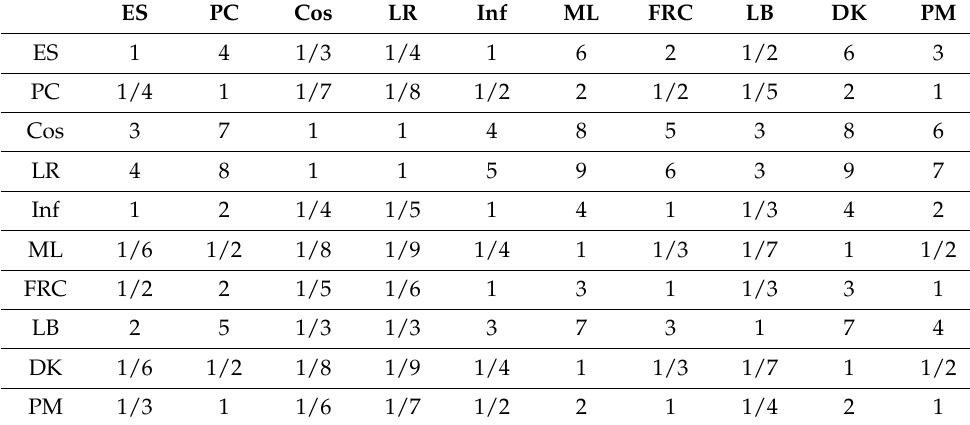
Table 6. Relative scores of criteria.